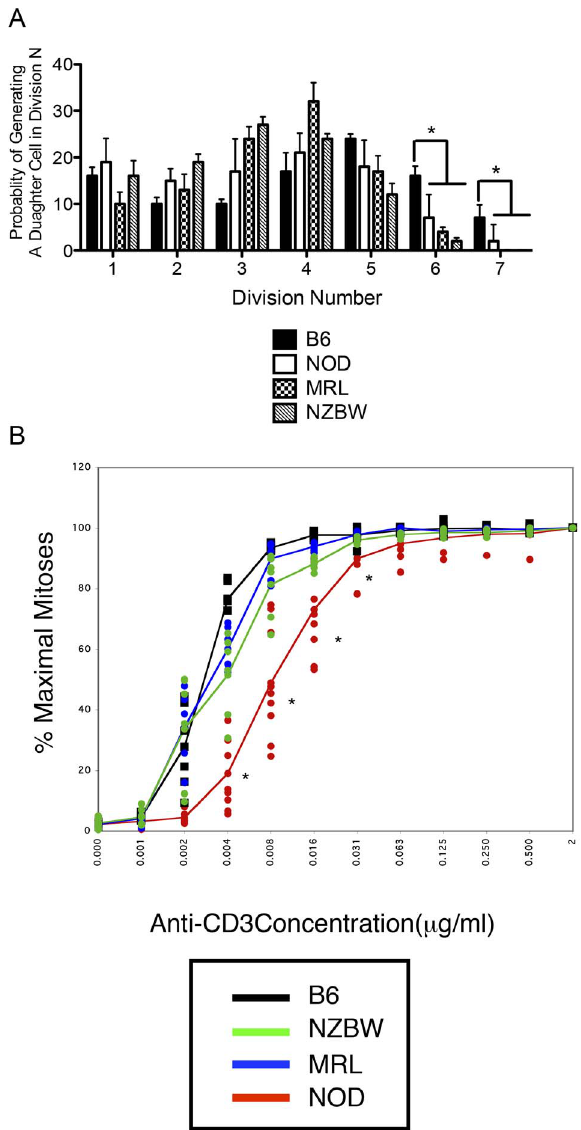
Figure 6. CD8 T cells from all strains are able to reach advanced cell divisions. A) The probability that a dividing precursor generates a daughter cell in division N was calculated under maximally stimulating conditions (2 m g/ml anti-CD3/28, 65 hours) and represented as a bar graph (n=6 for all strains). Differences in response were most evident in later divisions (*p , 0.05, B6 vs all other strains, ANOVA followed by Bonferroni post-test). B) Dose Responsiveness of autoimmune CD8 T cells to anti-CD3 mediated stimulation. The number of mitoses per 10,000 CD4 T cells was determined for cultures stimulated with a range (0–2 m g/ml) of anti-CD3 concentrations; each culture received 4 m g/ml anti-CD28. The percent of the maximal mitosis is shown plotted against the dose of anti-CD3. The NOD CD8 T cells exhibit a dose-response curve that diminishes more rapidly than the other strains. Significant differences in response are noted at the lower concentrations of anti- CD3 (n . 6 for all strains, *p , 0.01, NOD vs all other strains, ANOVA followed by Bonferroni post-test). Presented data are obtained from two separate experiments.